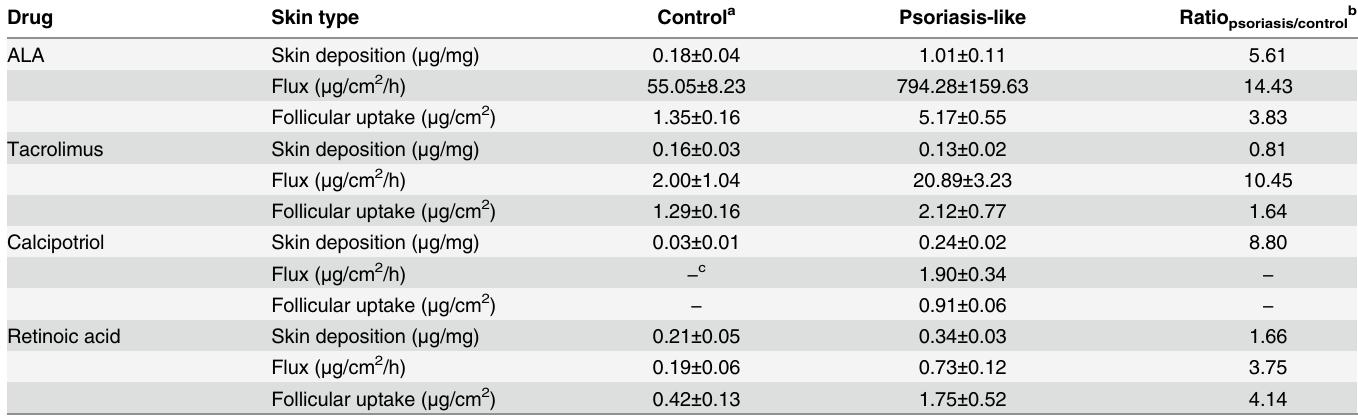
Table 3. The comparison of skin permeation profiles of 5-aminolevulinic acid, tacrolimus, calcipotriol, and retinoic acid via control and psoriasis- like skins.